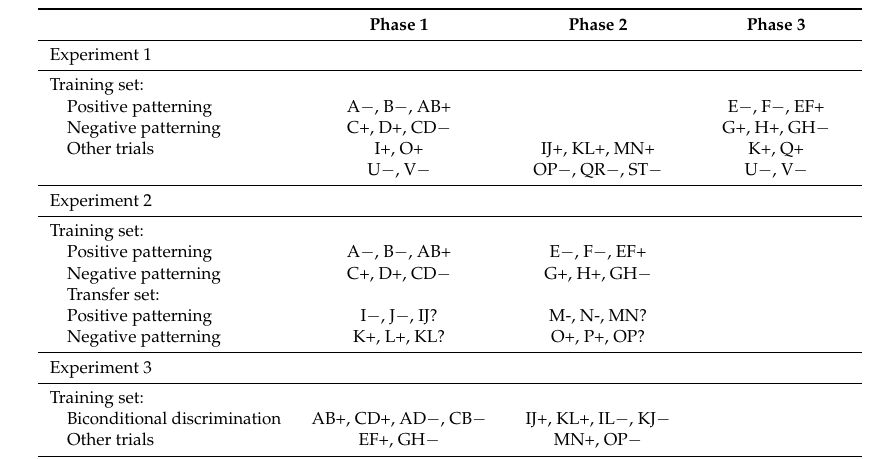
Table 1. Learning tasks designs 1